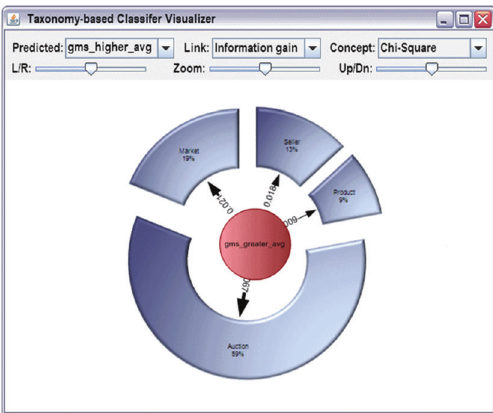
Figure 8: Concept hierarchy and multilevel h-data cone.